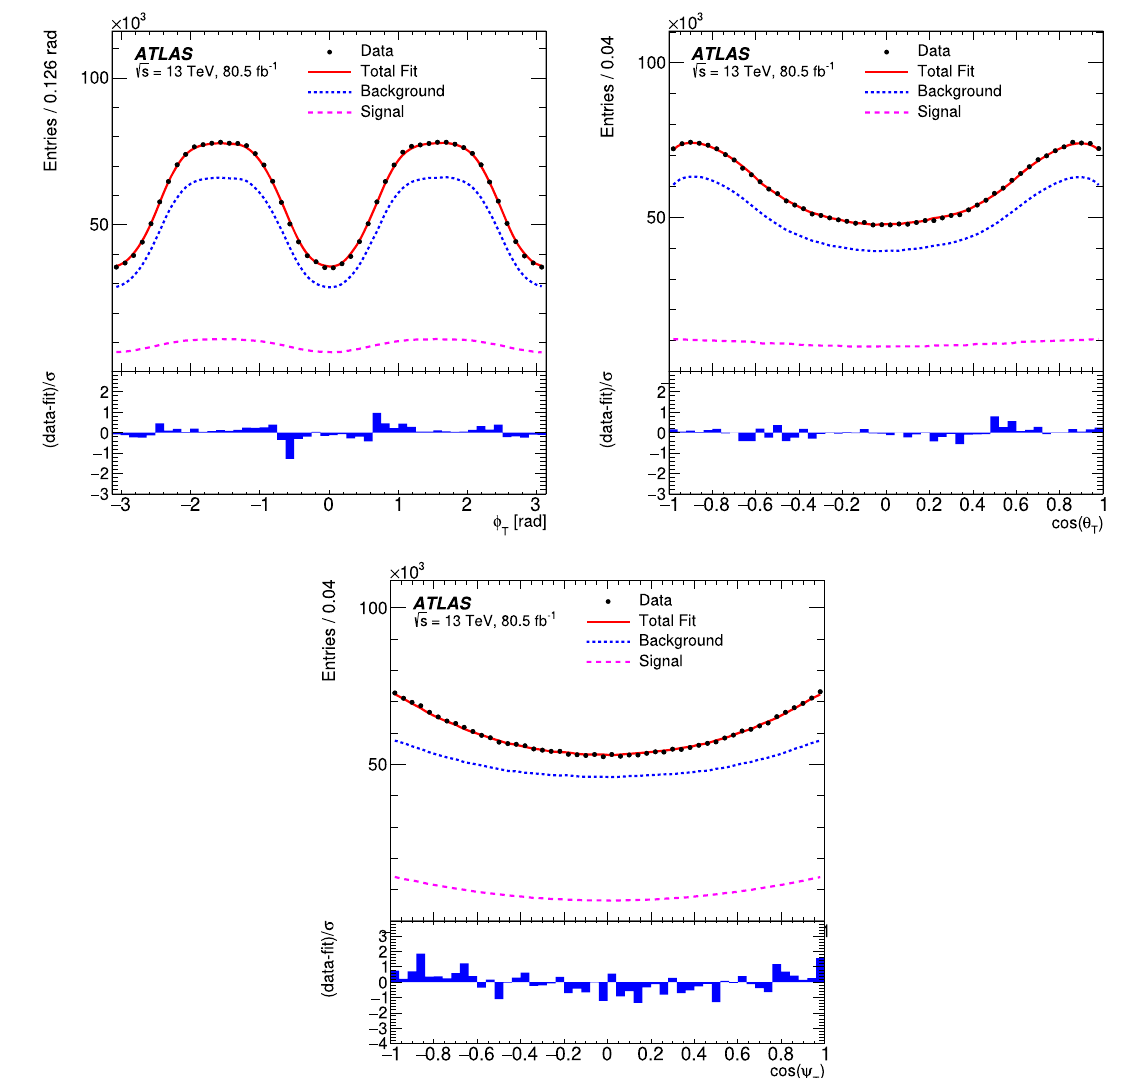
Fig. 8 Fit projections for the transversity angles φ T (top left), cos (θ T ) (top right), and cos (ψ T ) (bottom). In all three plots the red solid line shows the total fit, the B 0 s → J /ψφ signal component is shown by the magenta dashed line and the blue dotted line shows the contribution of